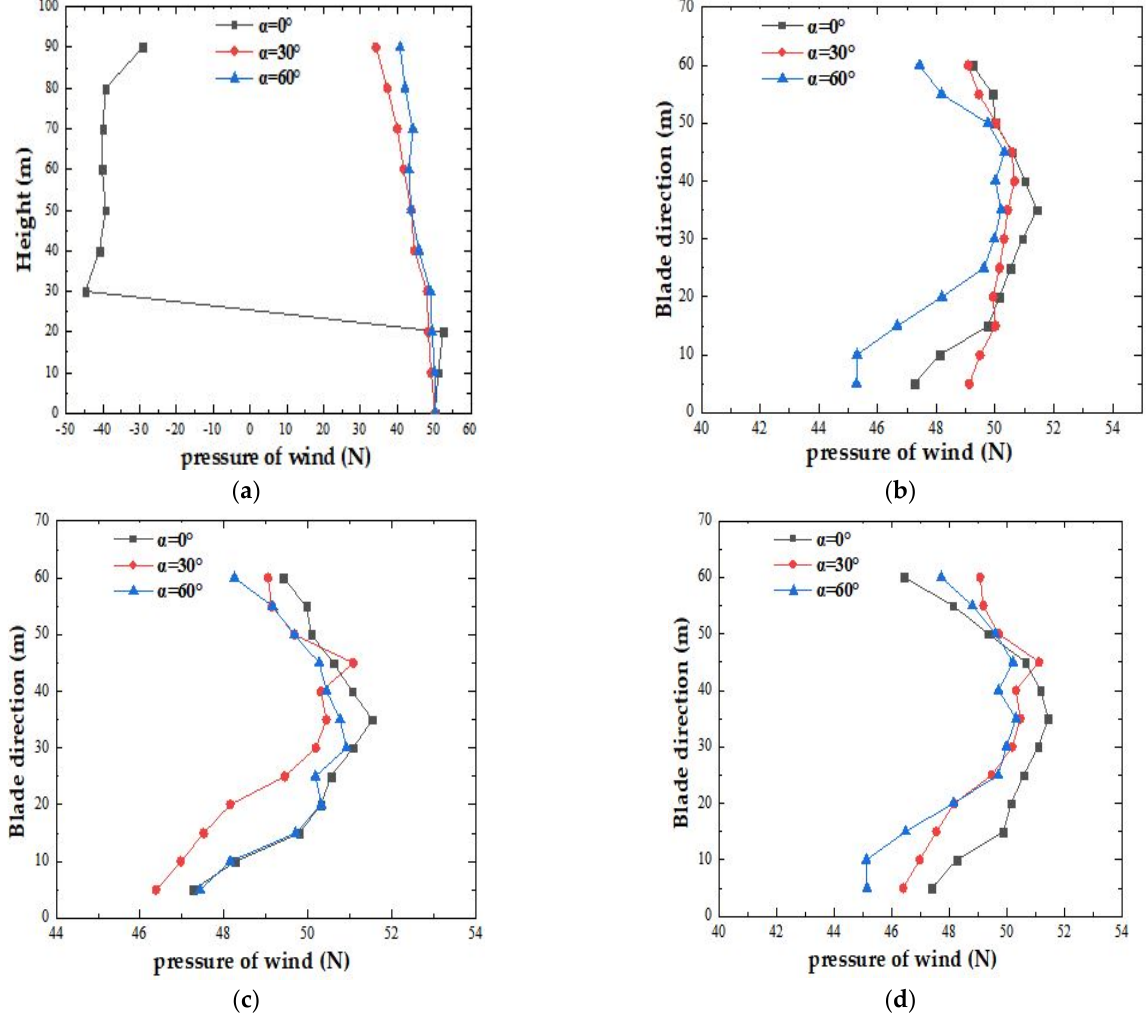
Figure 10. Wind-induced load distribution on ( a ) tower; ( b ) blade A; ( c ) blade B; ( d ) blade C.